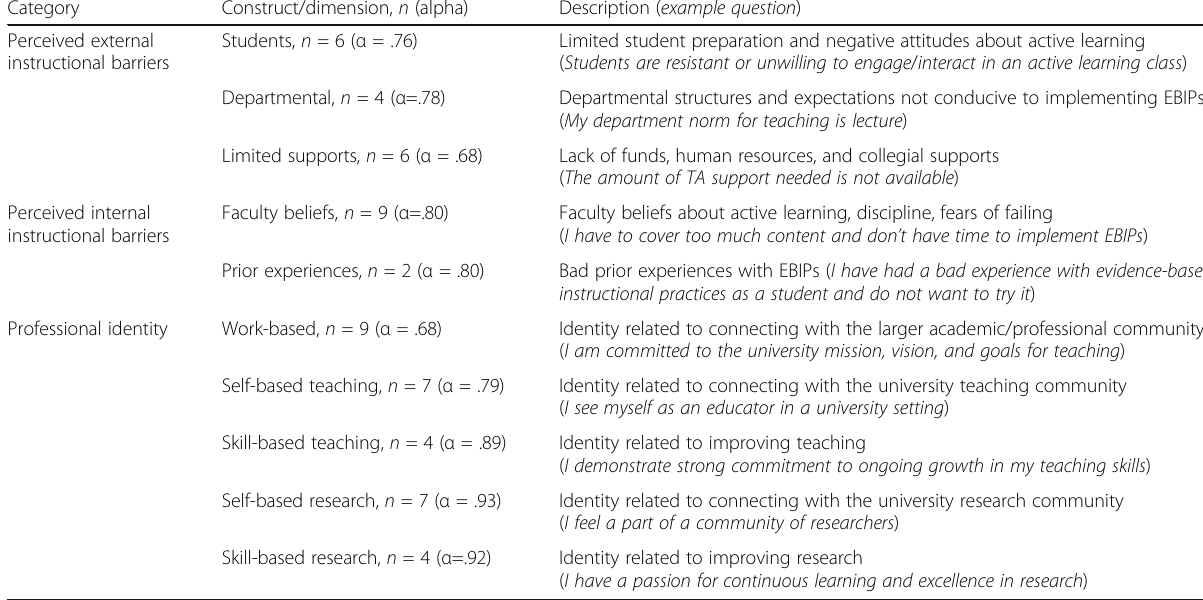
Table 6 Overview of instructional barriers and professional identity constructs